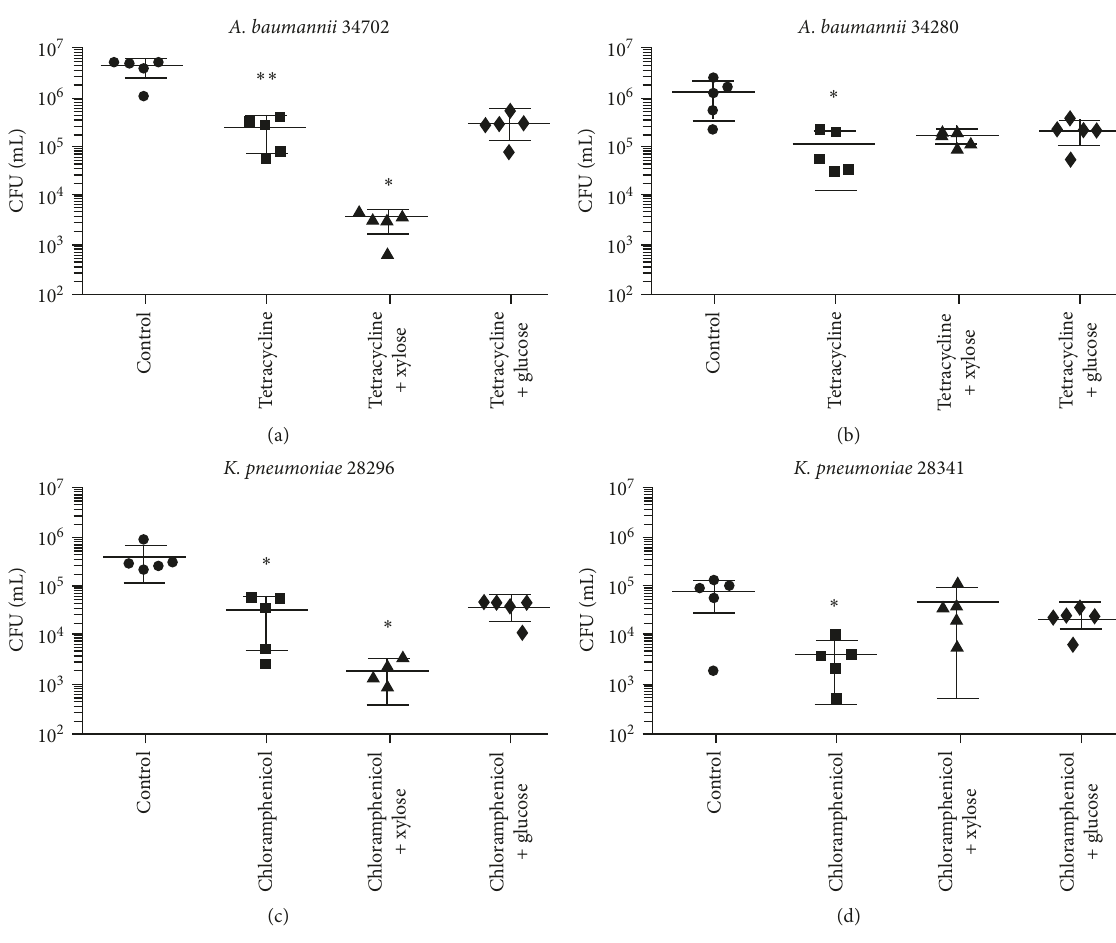
Figure 1: Xylose potentiates antibiotic activity of efflux-dependent resistant bacteria in a murine model of skin infection. The ability of xylose to increase the susceptibility of clinical A. baumannii and K. pneumomiae strains to tetracycline and chloramphenicol, respectively, was determined in vivo . Bacteria were used to infect skin lesion in mice, prior to treating mice with the antibiotic alone or with a mixture of the antibiotic and xylose. As control, a group of mice was treated with antibiotic and glucose, while another was left untreated. We tested the EDR strain A. baumannii 34702 (a) and the EIR strain A. baumannii 34280 (b) with tetracycline; and the EDR strain K. pneumomiae 28296 (c) and the EIR strain K. pneumomiae 28341 (d) with chloramphenicol. Results are expressed as CFU/mL of homogenized tissue. Ex- periments were repeated at least 3